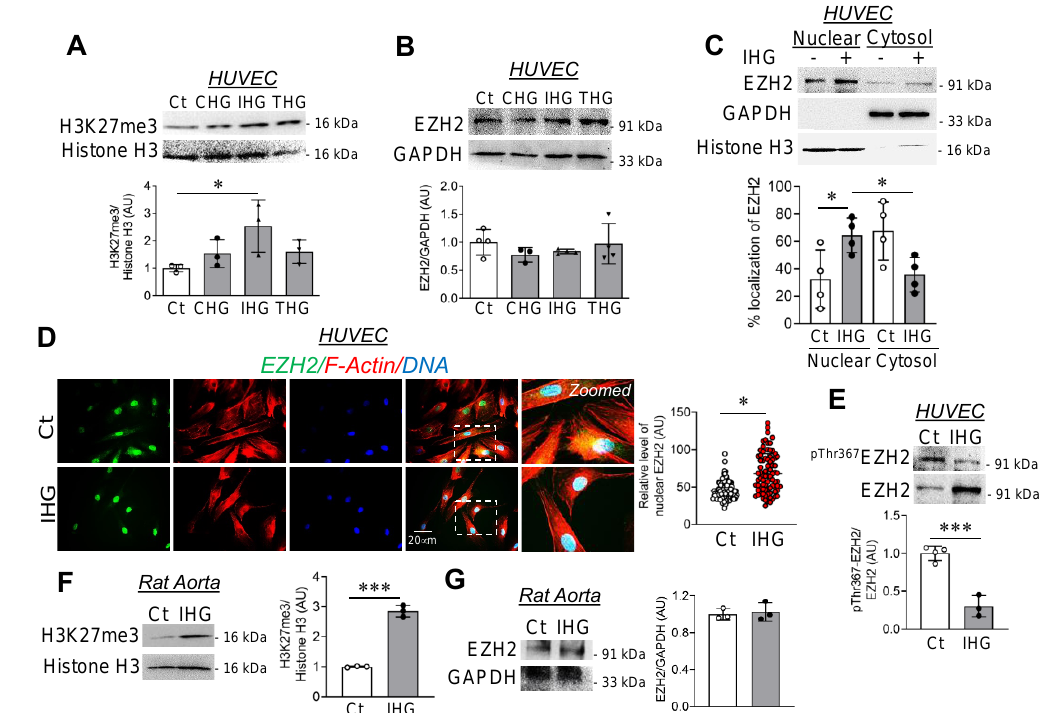
Figure 2. Intermittent high glucose induces nuclear localization of EZH2 through de-phosphorylation of threonine 367. ( A , B ) Immunoblotting and quantitation of differential hyperglycemia-treated HUVEC lysates for H3K27me3 (( A ), n = 3) and EZH2 (( B ), n = 4). ( C ) Subcellular fractionation, immunoblotting, and quantitation of nuclear and cytosolic level of EZH2 in intermittent high glucose-challenged HUVEC ( n = 4). ( D ) Immunofluorescence and quantitation of HUVEC for EZH2 (green) after intermittent high glucose treatment. F-actin staining through phalloidin shown in red and DAPI staining shown in blue. Fluorescence intensity values taken for individual cells are each indicated by dots, and at least n > 100 cells were analyzed per group from three independent experiments. ( E ) Immunoblotting and quantitation of threonine 367 phosphorylated EZH2 in intermittent high glucose-exposed HUVEC ( n = 4). ( F , G ) Tissue lysates of intermittent high glucose-treated rat aortic rings were immunoblotted and quantified for H3K27me3 ( F ) and EZH2 ( G ) ( n = 3). Control treatment condition (cells constantly exposed to normal glucose (5.5 m M)) represented as “Ct” in the figure. All analyzed data were normalized to the control treatment condition. Values represent the mean ± SD. * p < 0.05 and *** p < 0.001 by unpaired t test.